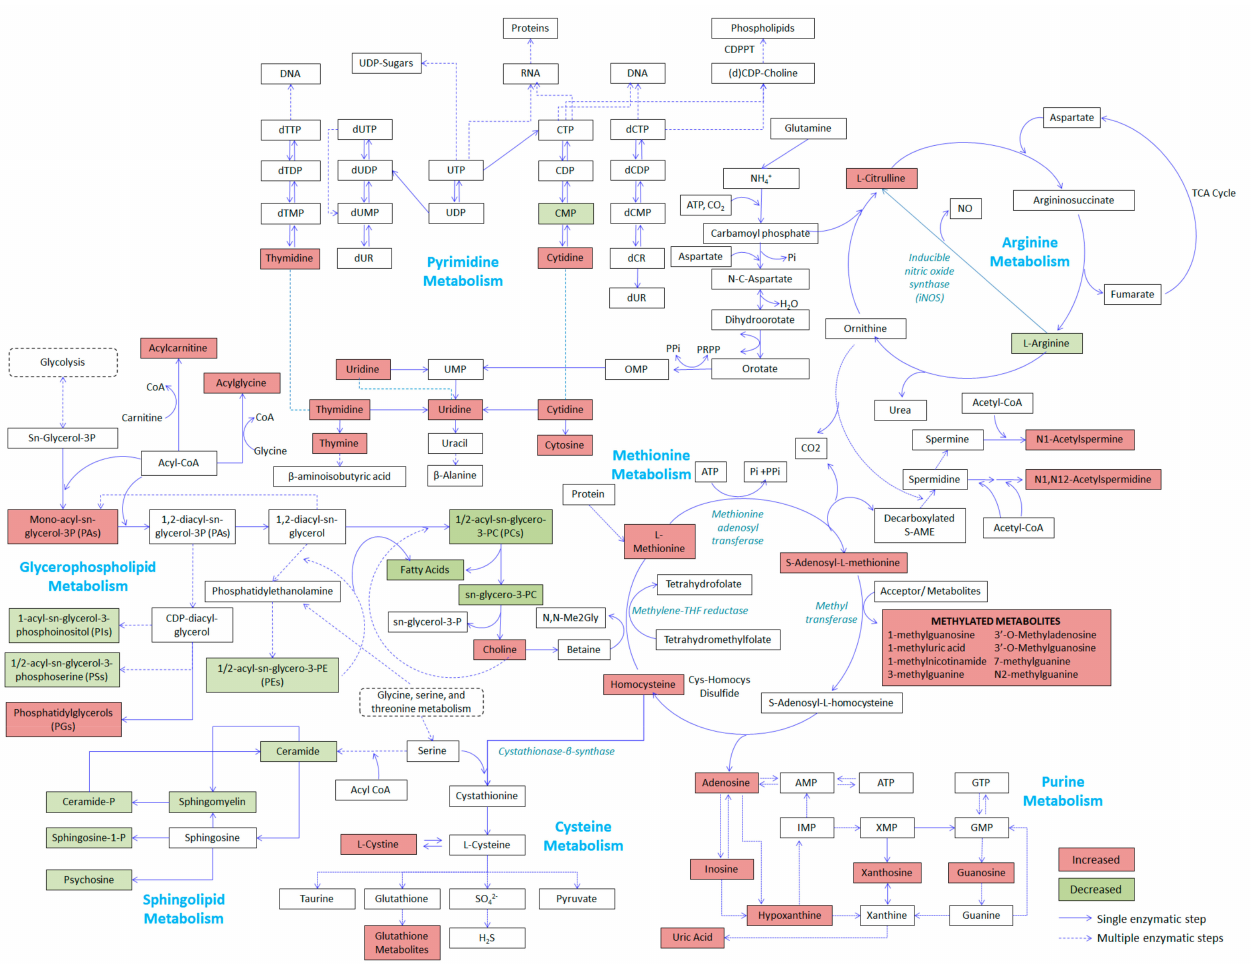
Figure 5. Schematic representation of the top metabolic pathways perturbed after trauma injury. Metabolites in red boxes are those found to have significantly increased after trauma compared to sham, while those in green boxes are those significantly reduced after the injury. Arrows with solid lines represent direct conversions through single enzymatic steps, while those with dashed lines are those requiring multiple enzymatic